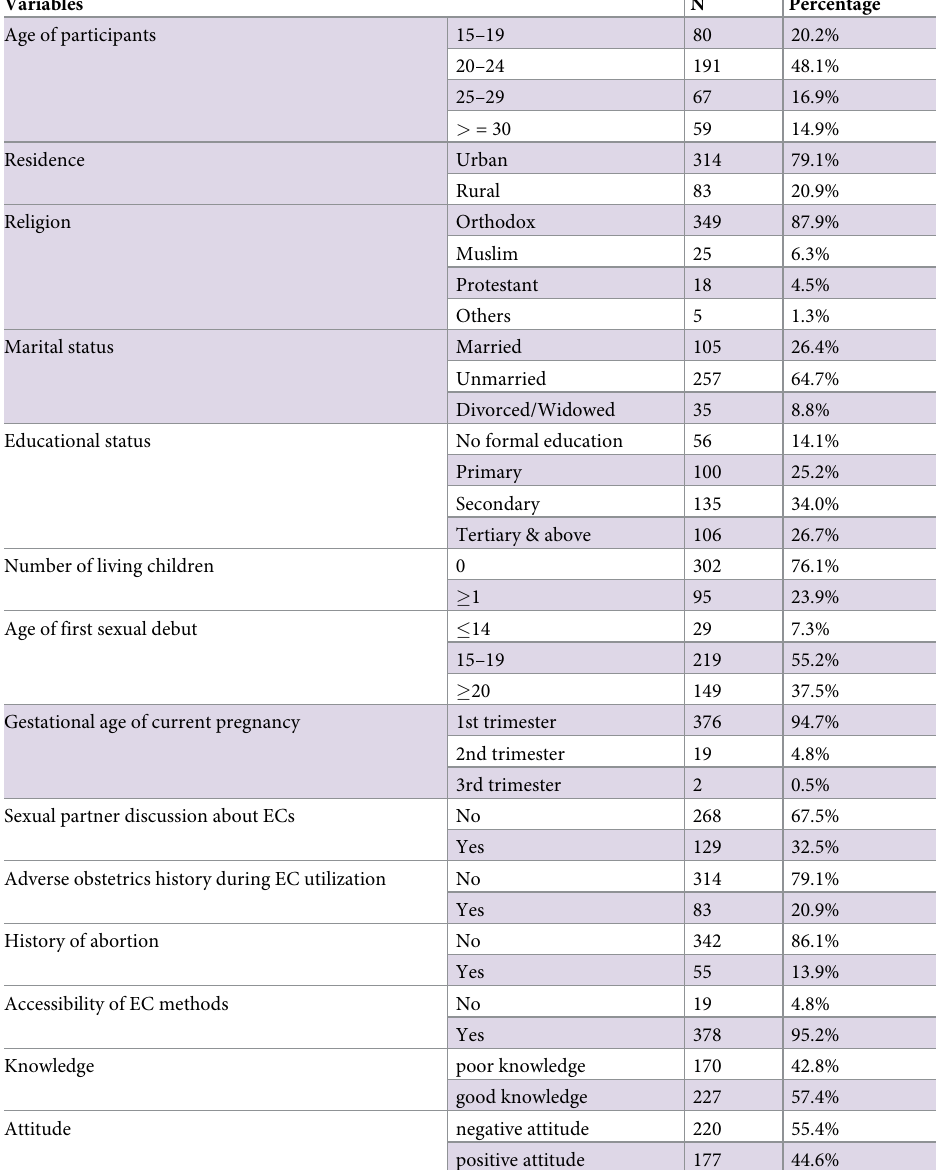
Table 1. Socio-demographic and sexual and reproductive characteristics of 397 women seeking termination of pregnancy, Northwest Ethiopia, 2019.